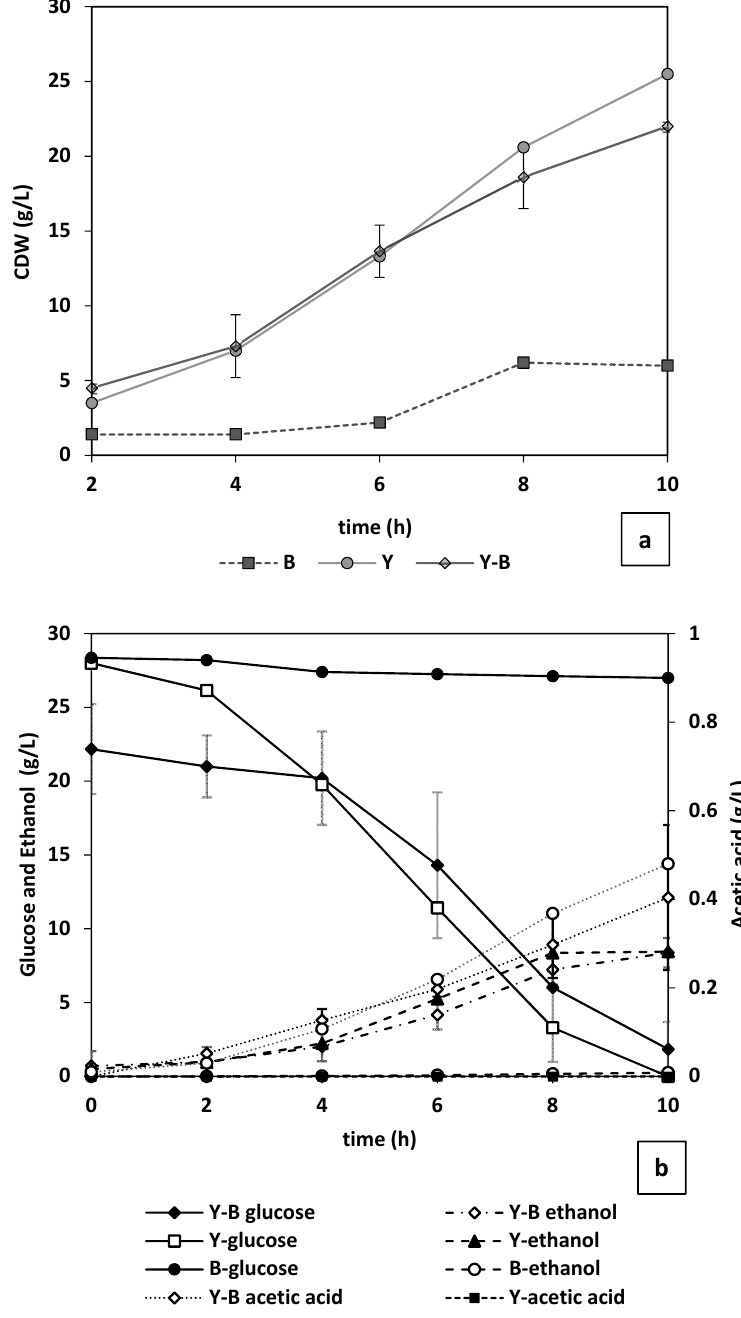
Figure 8. Changes in ( a ) cell dry weight and ( b ) substrate and metabolites in the reactor during batch fermentation. The figure legends Y, B and Y-B represent samples containing only yeast, only bacteria, and both bacteria and yeast, respectively. The error bars represent ±2 standard deviations.